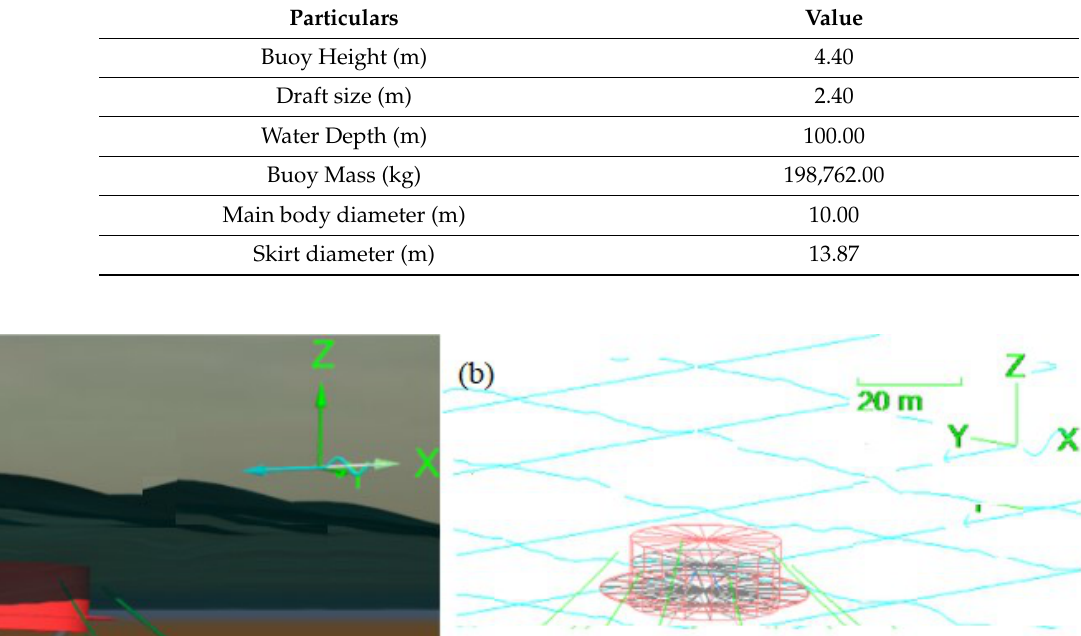
Table 1. Parameters for the Buoy.